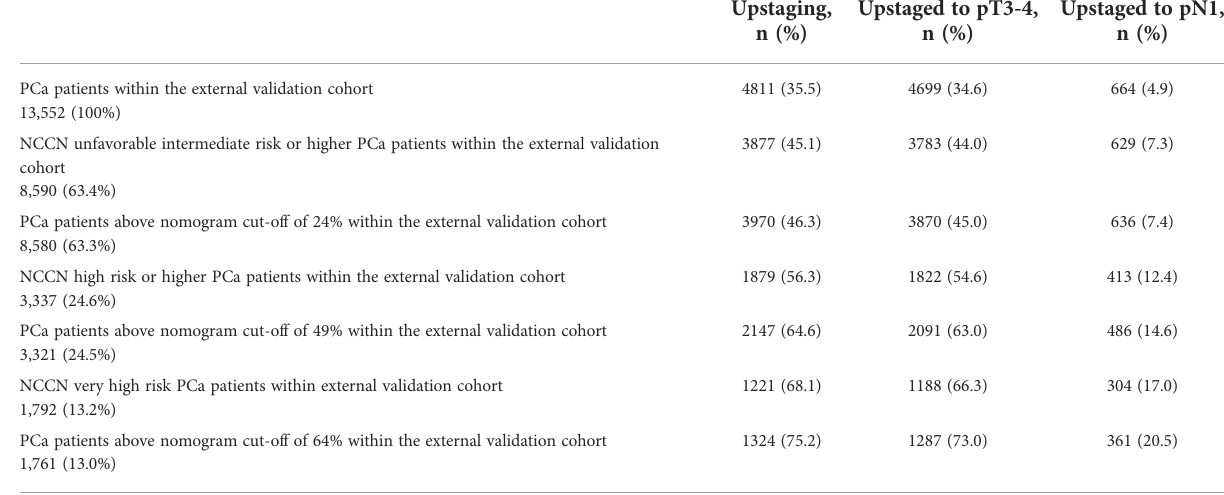
TABLE 2 Rates of upstaging according to NCCN risk groups and nomogram cut-offs of 24%, 49% and 64%.